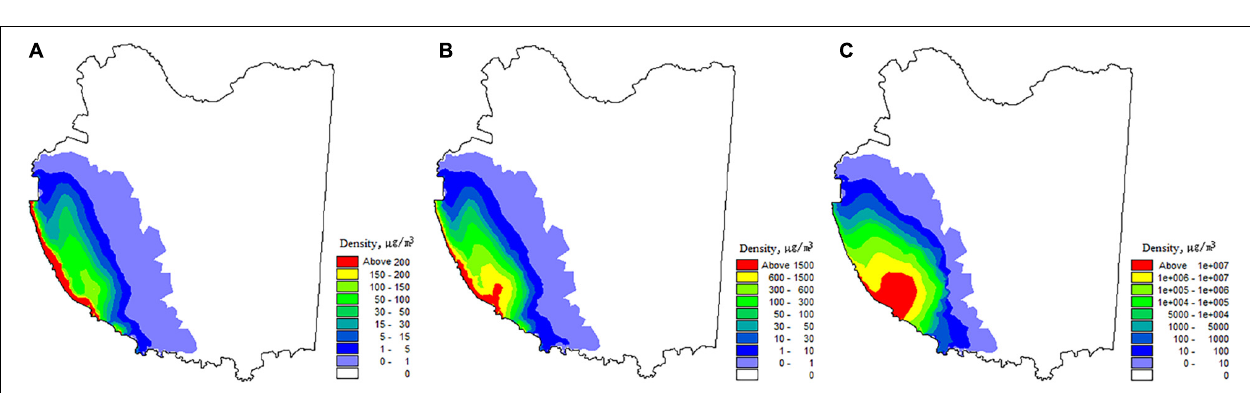
FIGURE 12 | The density profile of alien phytoplankton under different conditions in Tianjin port. (A) Condition 1. (B) Condition 2. (C) Condition 3.